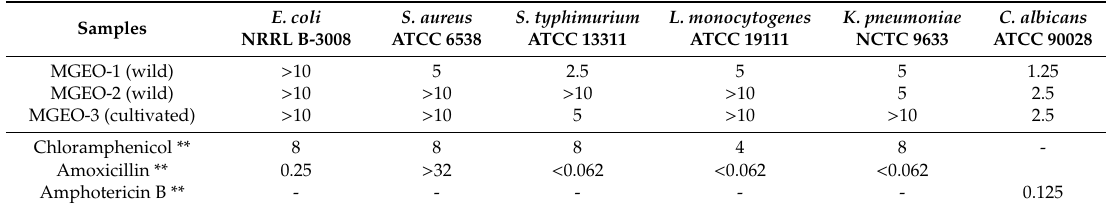
Table 7. Antimicrobial activity of MGEOs 1-3 (MIC *, mg / mL).